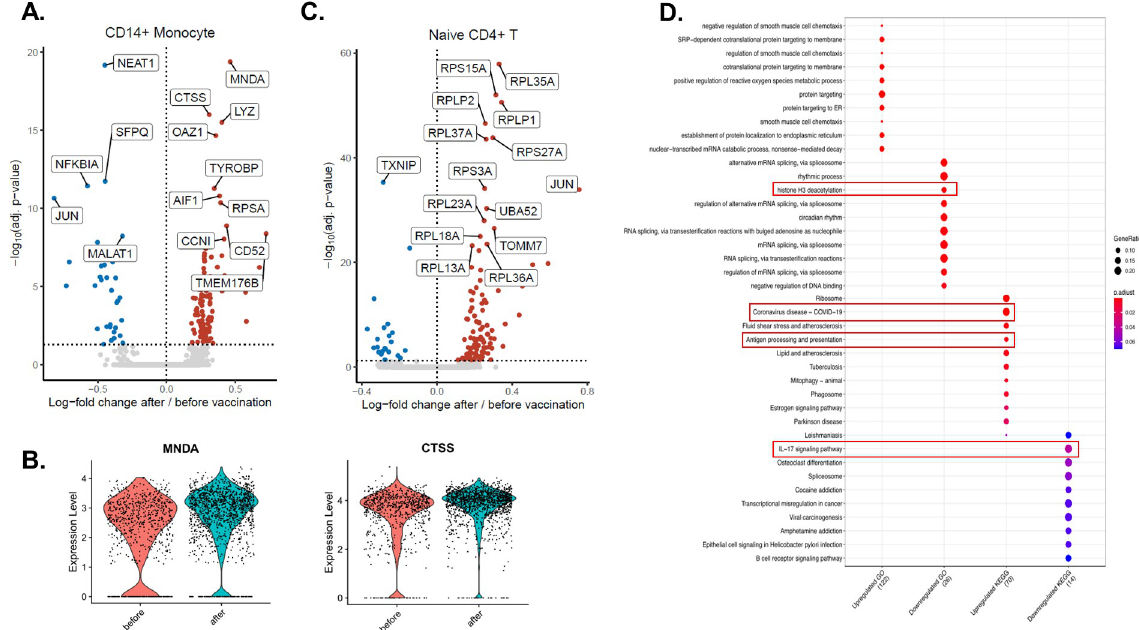
Fig 2. Transcriptomic changes induced by influenza vaccination on a single cell level. A. Volcano plot depicting the upregulated and downregulated genes in CD14+ monocytes 6 weeks after influenza vaccination. Red dots show upregulation, while blue dots show downregulation. B. Violin plots showing the expression levels of MNDA and CTSS before and after vaccination in CD14+ monocytes. C. Volcano plot depicting the upregulated and downregulated genes in CD4+ na ï ve T cells 6 weeks after influenza vaccination. Significantly changing top 15 genes were labeled on the volcano plots. D. Pathway analysis of genes up-regulated or down-regulated by influenza vaccination.